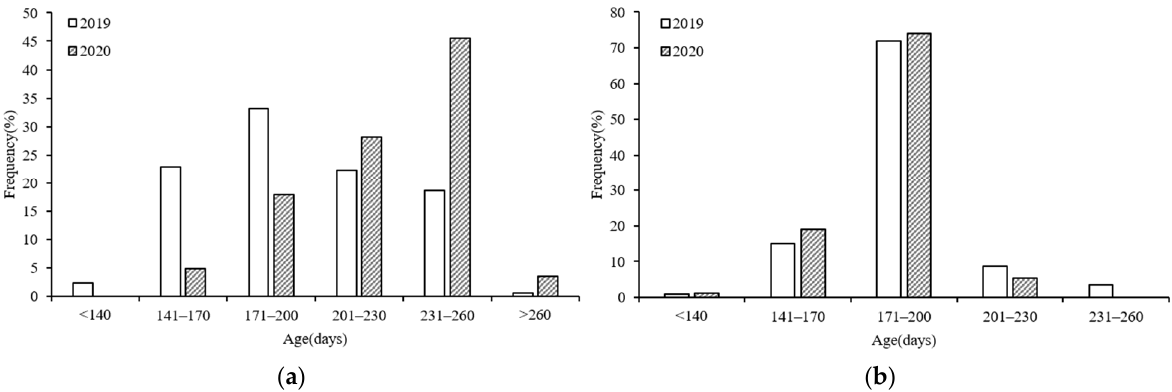
Figure 5. Age compositions of S. oualaniensis samples in different years: ( a ) female; ( b ) male.